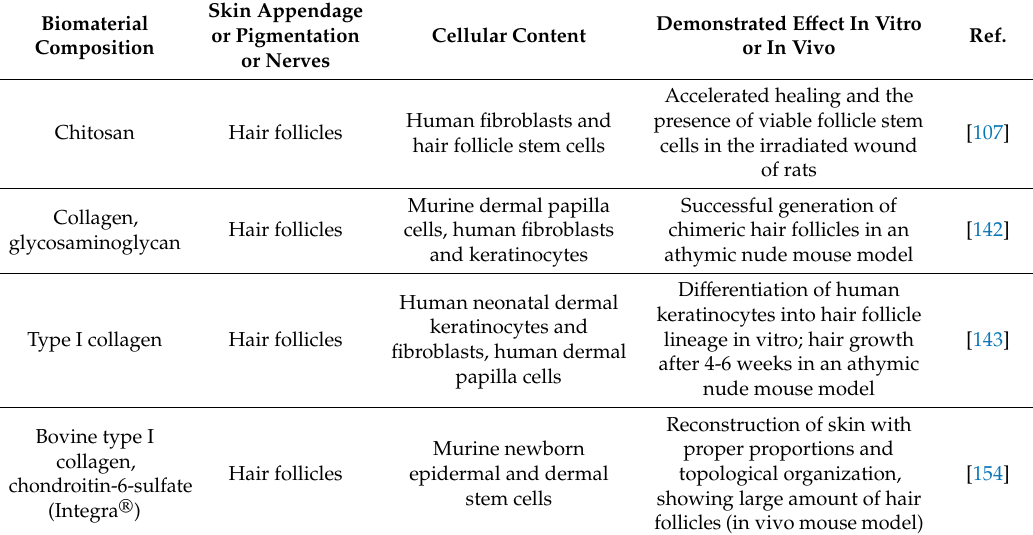
Table 3. Bioengineered artificial skin grafts designed for the reconstruction of skin appendages, pigmentation, and